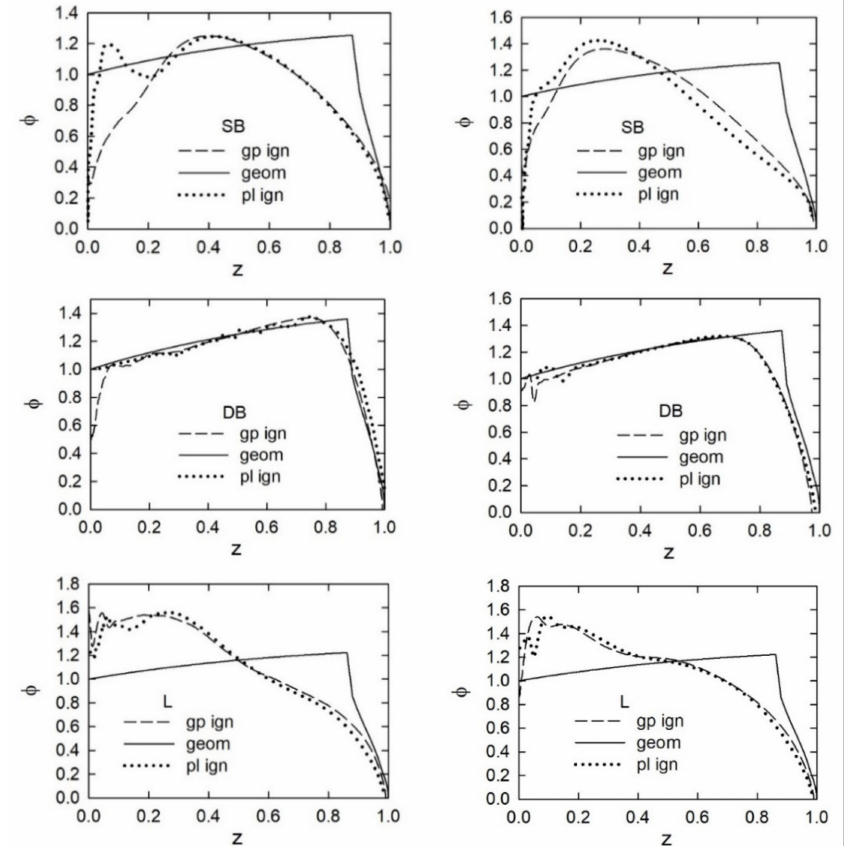
Figure 5. Plots of theoretical (geometrical) and experimental shape functions, where ∆ = 100 kg/m 3 ( left ) and ∆ = 200 kg/m 3 ( right